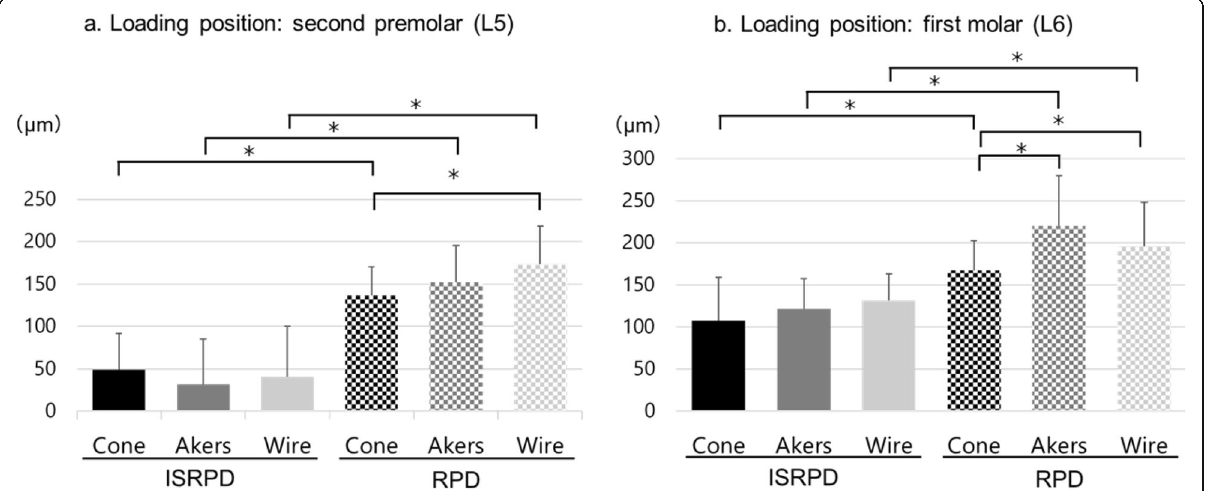
Fig. 7 Amount of vertical displacement at the end of the denture base. Data are expressed as the mean displacement at the end of the denture base of each direct retainer, and error bars represent the standard